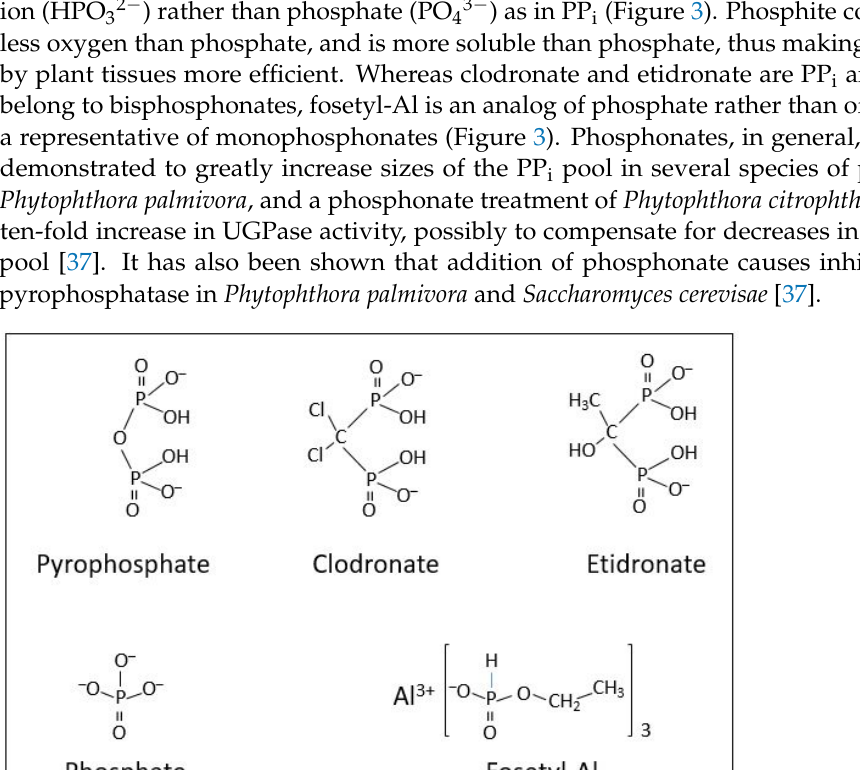
Figure 4. Effects of etidronate, clodronate and fosetyl-Al on activity of barley UGPase, assayed for the pyrophosphorolysis direction, at low ( A ) and saturating ( B ) concentrations of both UDPG and PP i . The phosphonates were at 1 mM each. Statistical significance in relation to control: ** ( p < 0.01). We examined the effects of fosetyl-Al in more detail using Dixon plots [24,38], where activity of the enzyme, assayed in the pyrophosphorolysis direction, was determined at various concentrations of fosetyl-Al and using a fixed saturating concentration of one sub- strate and different concentrations of the second reactant (Figure 5). Inhibition constants ( K i ) for fosetyl-Al against each of the UGPase substrates could be estimated from intersec- tion of lines on the Dixon plot [24,38]. The K i values estimated from Dixon plots were ap- proximately 0.15 mM (with PP i varied) and 2.3 mM (with UDPG varied). The intersection points above the X -axis have indicated that the inhibitor is not uncompetitive or noncom- petitive versus PP i or UDPG. Plotting of the slopes versus the inverse of the substrate concentration allowed us to determine whether the inhibition was of pure competitive or mixed character; in the case of competitive inhibition the crossing trough “zero” would indicate that addition of infinite amounts of substrates prevents inhibitor effects. In con- clusion, based on data in Figure 5, the nature of the fosetyl-Al inhibition versus PP i is near- competitive, while its inhibition versus UDPG appears to be of mixed character [24,38].